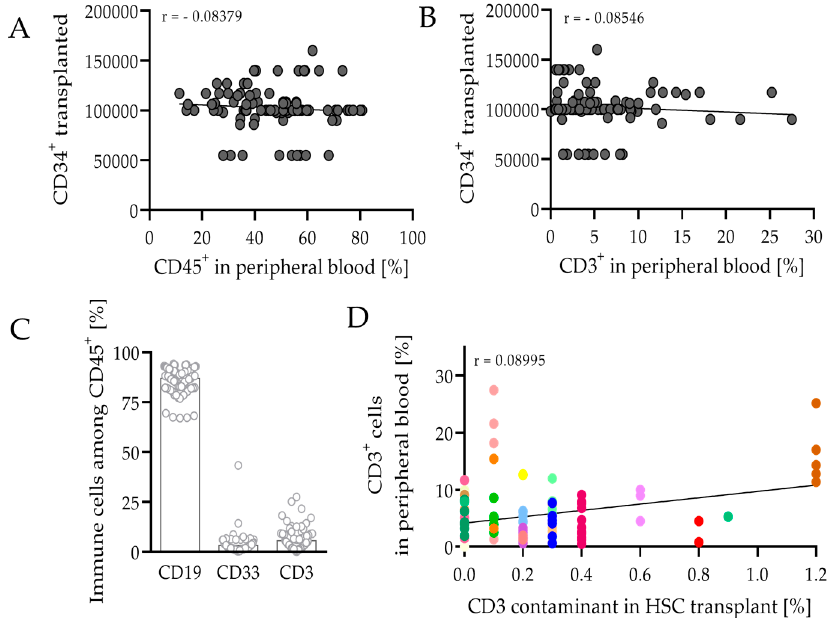
Figure 1. Engraftment success of the human immune system in mice 8–9 weeks after transplantation. ( A ) Frequency of reconstituted leukocytes (CD45 + ) and (B) T cells (CD3 + ) in peripheral blood of mice did not correlate with the transplanted number of CD34 + cells, analyzed by flow cytometry (mean). The linear regression is shown (Pearson’s correlation coefficient ( A ) r = − 0.08379 and ( B ) r = − 0.08546). ( C ) Distribution of reconstituted B cells (CD19 + ), myeloid cells (CD33 + ), and T cells (CD3 + ), among CD45 + leukocytes isolated from peripheral blood are depicted (mean). ( D ) Reconstitution of T cells in peripheral blood was determined by flow cytometry in comparison to T cell contaminant in the cord blood before transplantation. Each symbol represents one individual mouse. Individual colors display one particular transplant injected in several mice, respectively ( n = 95).